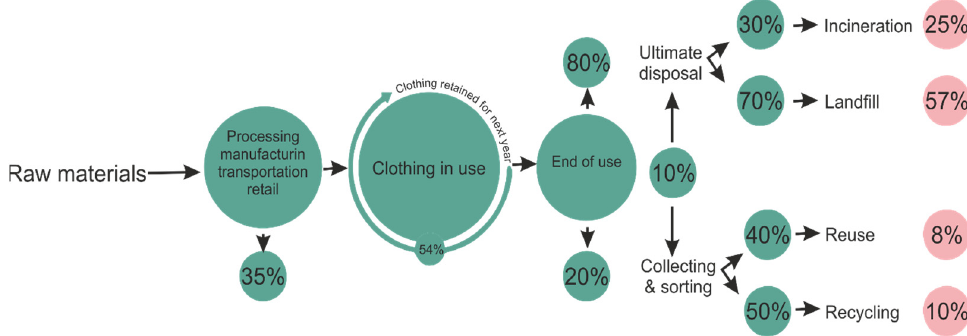
Figure 1. Pre- and post-consumer waste in the clothing industry [1].